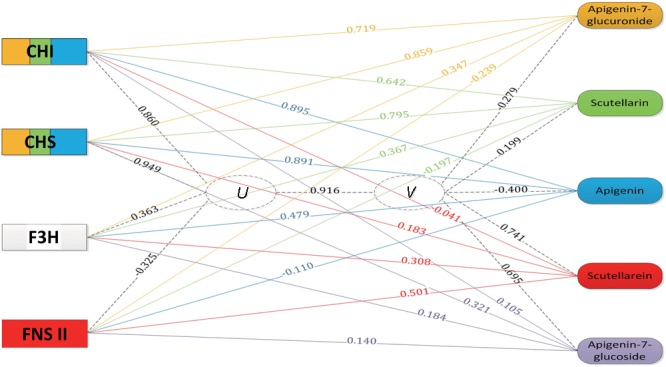
Gene-to-metabolite network in MeJA-induced E. breviscapus plants. Genes are represented by squares on the left and metabolites on the right. The canonical correlation coefficient between the canonical correlation variables (U and V) was 0.916. The correlation coefficients between the raw variables (genes and metabolites) and canonical correlation variables (U and V) are shown on the corresponding dotted line. The color in the gene square represents the level of gene-to-metabolite correlation, and edges were drawn when the variable correlation coefficient was >0.50; for example, a larger blue area represents more correlation to apigenin.